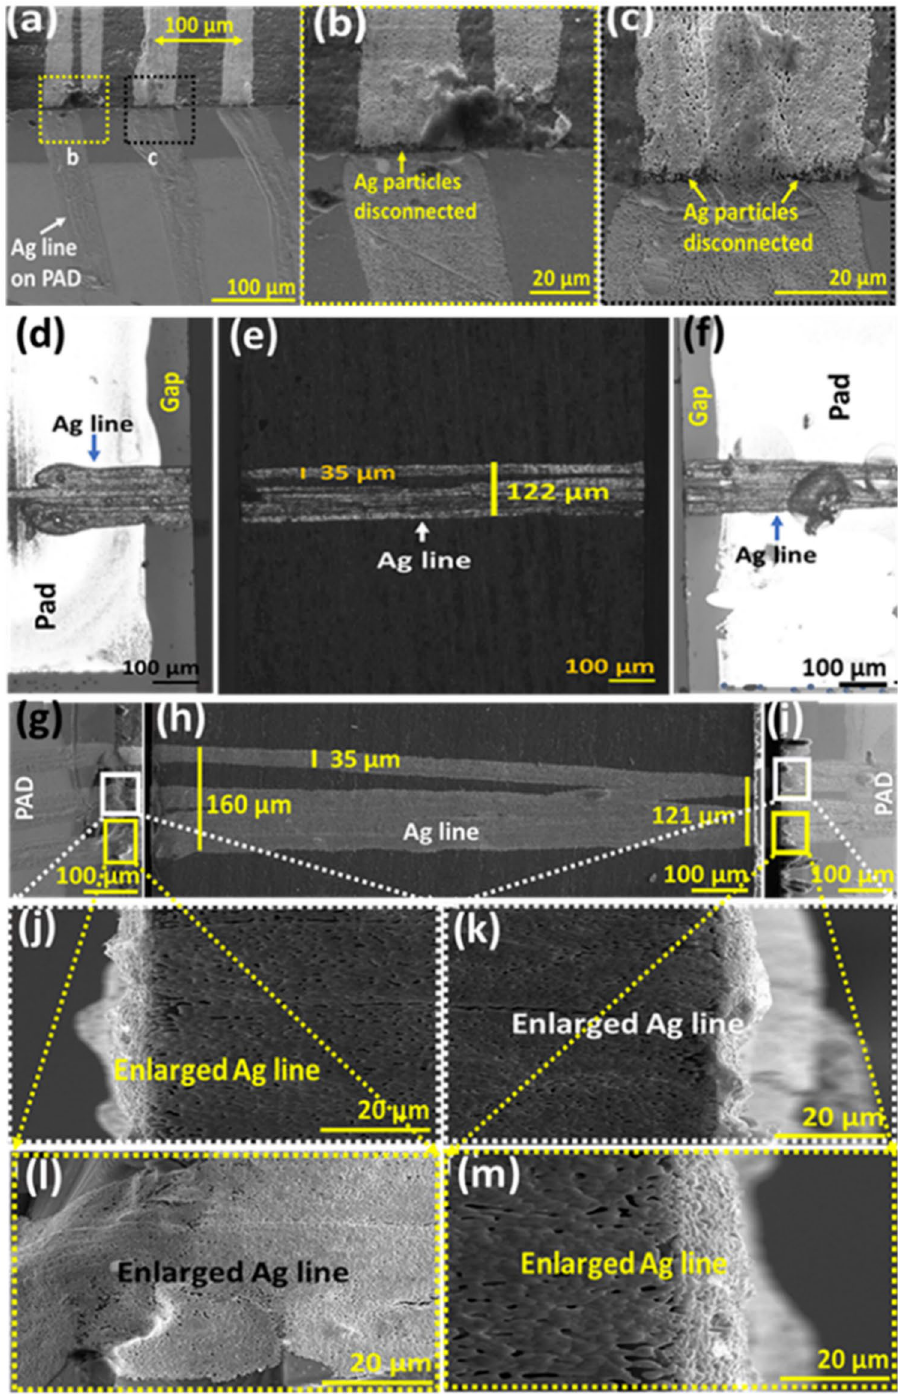
Figure 5. Optical microscopy and SEM images of printed lines. ( a ) Printed lines with 100 μm spacing. ( b ) Enlarged edge parts with line disconnection. ( c ) Enlarged edge parts with partial disconnection. ( d – f ) Optical microscopy images of multiple printed lines. ( g – i ) SEM images of multiple printed lines. ( j – m ) Enlarged image at the